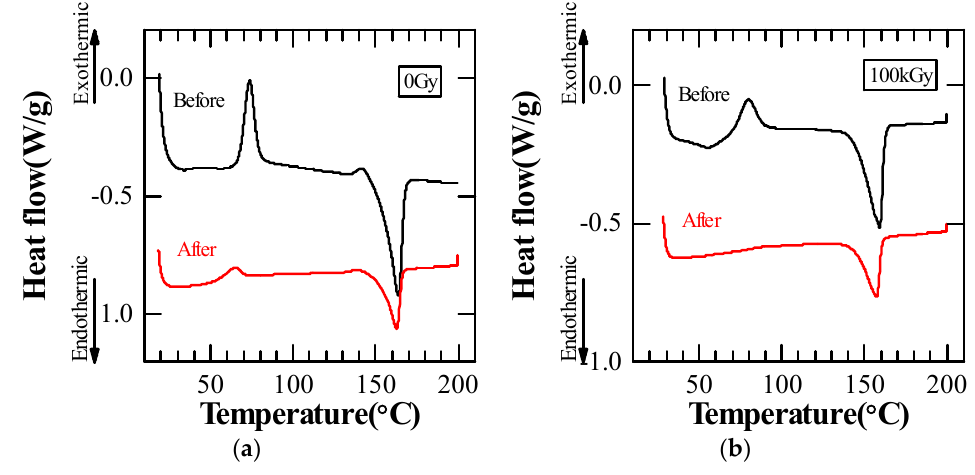
Figure 12. DSC curves of PLA ‐ 80 (( a ) 0 Gy and ( b ) 100 kGy) before and after the dielectric breakdown test at 80 °C.